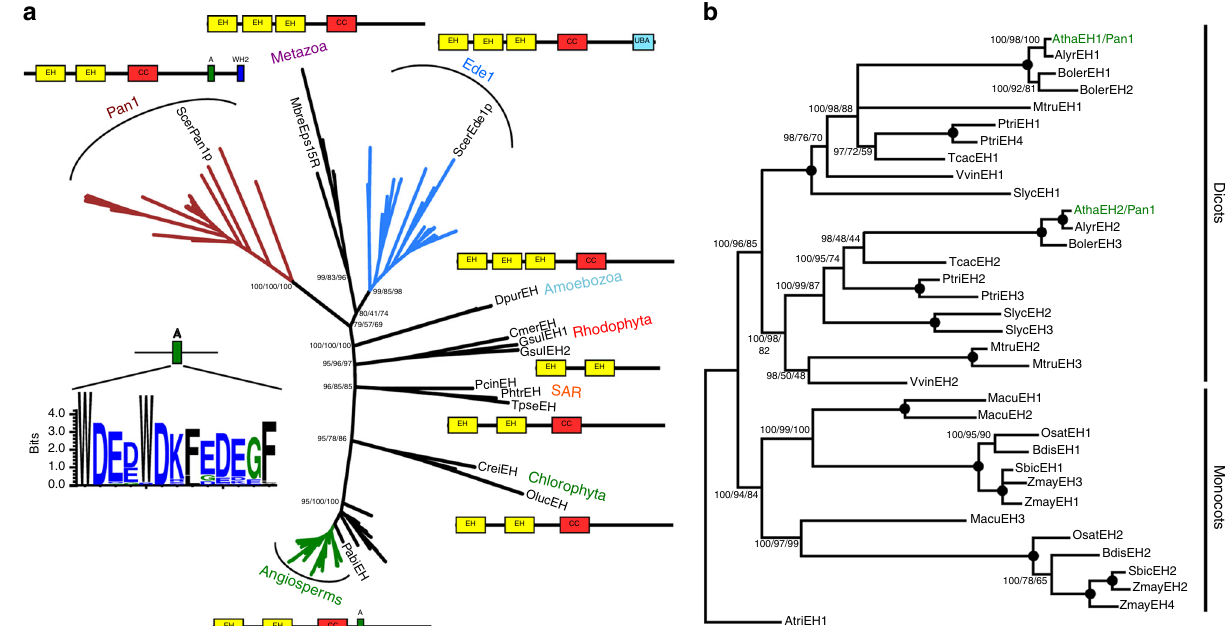
Fig. 1 Phylogenetic analysis and domain architecture points to both Arabidopsis AtEH proteins as homologues of yeast Pan1p. a Phylogenetic tree for Pan1 homologues shows that Plant AtEH/Pan1 proteins form a well-supported clade with a domain organization similar to yeast Pan1p. Interestingly, the Amoebozoa seem to possess homologous proteins with a domain architecture resembling more to Ede1 than to Pan1. A — acidic motif, EH — Epsin15- homology domain, CC - coiled coil domain, UBA — ubiquitin-associated domain, WH2 — WASP-homology 2 domain, Dpur — Dictyostelium purpureum, Cmer — Cyanidioschyzon merolae, Gsul — Galderia sulphuraria, Mbre — Monosiga brevicollis, Pabi — Picea Abies, Pcin — Phytophtora cinnamomi, Phtr — Phaedactylum tricornutum, Scer — Saccharomyces cerevisiae, Tpse — Thallasiosira pseudonana. The sequence logo representing the conservation of the acidic motif is shown left of the tree. b Detailed tree rooted to Amborella trichocarpa, which only possesses a single EH/Pan1 protein, showing that EH/ Pan1 proteins duplicated independently in Dicots and Monocots. Atha — Arabidopsis thaliana, Alyr — Arabidopsis lyrata, Atri — Amborella trichocarpa, Bdis — Brachypodium distachyon, Boler — Brassica oleracea, Mtru — Medicago truncatula, Macu — Musa acuminata, Osat — Oryza sativa, Sbic — Sorghum bicolour, Slyc — Solanum lycopersicum, Vvin — Vitis vinifera, Tcac — Theobroma cacao, Zmay — Zea mays. Numbers at nodes correspond to the posterior probabilities from the Bayesian analysis/RAxML bootstrap support/approximate likelihood ratio test with the SH-like (Shimodaira – Hasegawa-like) support from